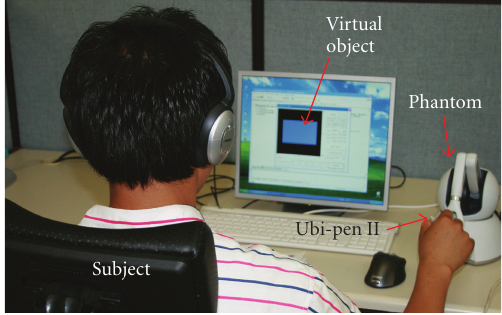
Figure 8: Force and tactile feedback interface.